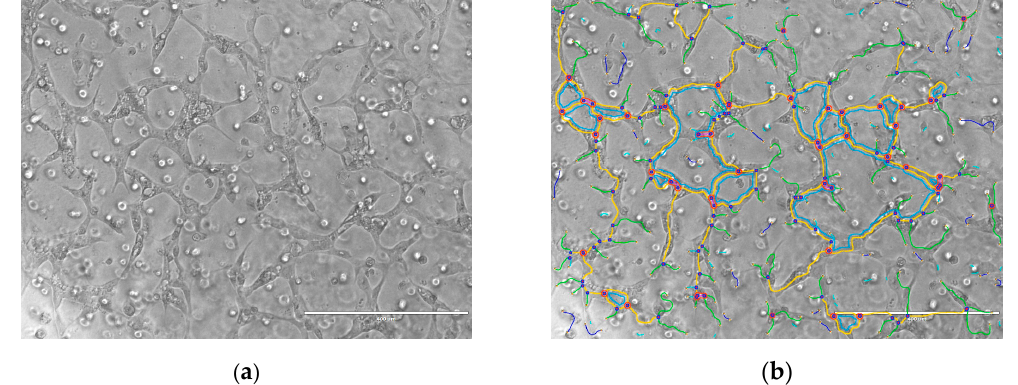
Figure 7. Example of an angiogenesis assay of HUVECs after exposure to 0.1 mg/mL vancomycin. Microscopic image of tube formation in Matrigel (a) and evaluation with the angiogenesis analyzer for ImageJ by Gilles Carpentier (2012) where different colors represent different parameters (b).